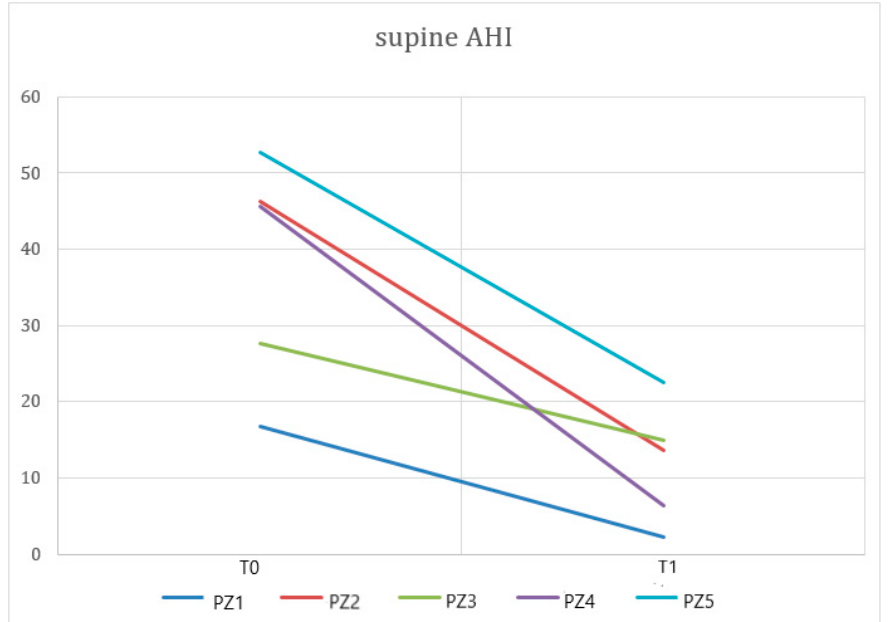
Figure 2. A paired data t-test showed a significant difference between AHI at T0 and T1 ( p < 0.05) when evaluating data from patients (PZ) treated with the OrthoApnea NOA ® device.